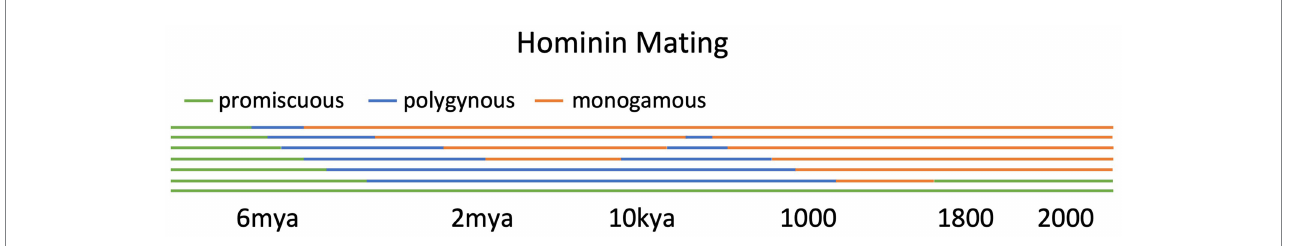
FIGURE 3 A possible evolution of mating practices. Global pattern until the Middle Ages, then Western. This figure synthesizes the works of Ågren and Erickson (2005), Chapais (2008, 2011), Fisher (2016), Henrich (2020), Karmin et al. (2015), Opie et al. (2013), Seccombe (1992), and Zeng et al.